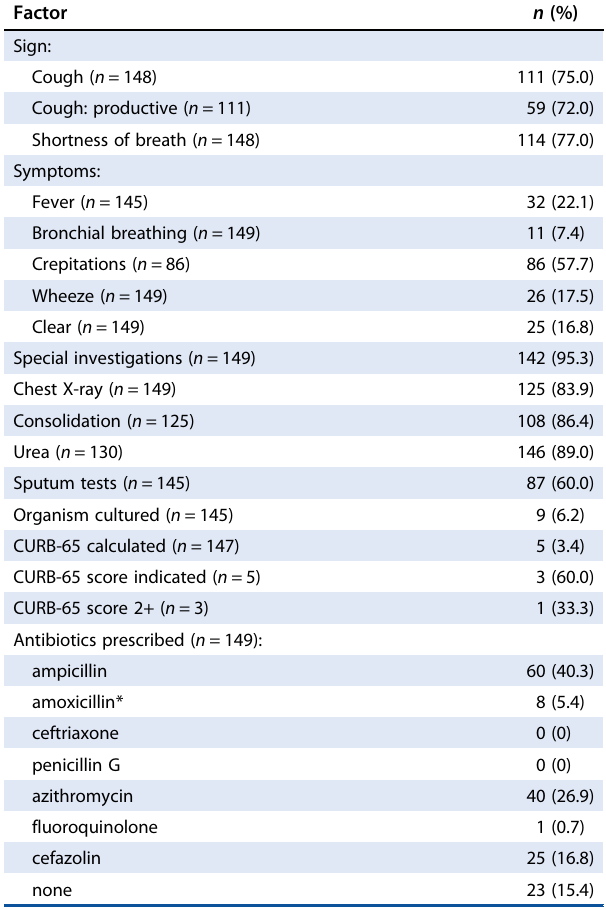
Table 1: The symptoms and signs of patients, investigations done and antibiotics